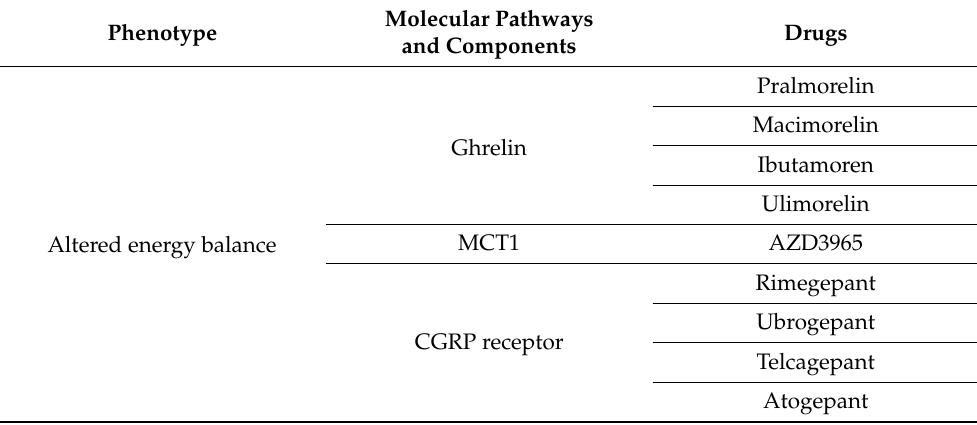
Table 5. Molecular pathways and respective drugs involved in altered energy